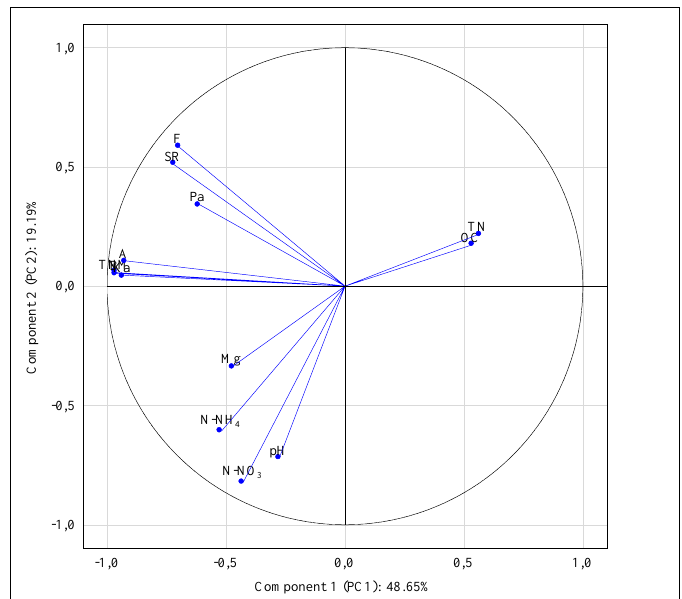
Figure 1. PCA analysis (principal component analysis PC1, PC2) of soil parameters: total number of microorganisms (TNM), bacteria (B), actinobacteria(A) fungi (F); soil respiratory activity (SR); pH in 1 M KCl (pH); organic carbon content (OC); content of available phosphorus (Pa), potassium (Ka), magnesium (Mg); content of total nitrogen (TN), mineral nitrogen forms: N-NO 3 and N-NH 4 . Ward's method